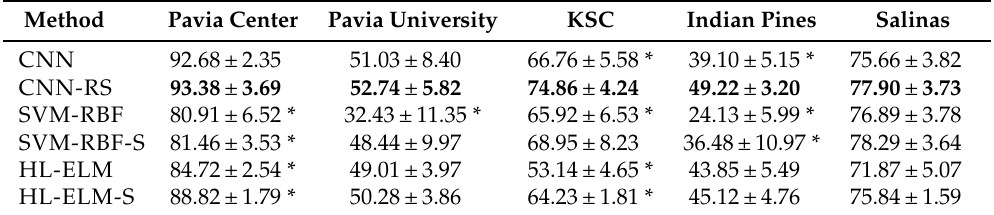
Table 11. Average classification accuracy of test data over 10 runs in the non-overlapping learning setting (see Section 2.2.2). The best accuracy for each dataset is indicated in bold. An ‘*’ means that the best accuracy is significantly better than the accuracy achieved by the corresponding method according to a binomial test for comparing classifiers [45] ( p -value <